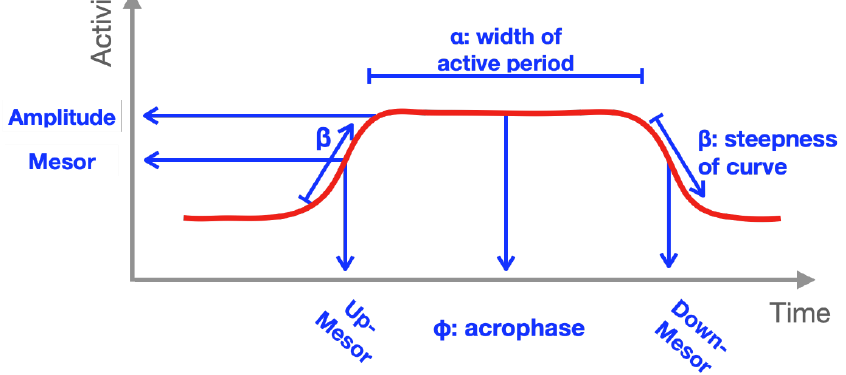
Figure 1. Schematic of parameters estimated from antilogistic extended cosine model and how they impact the size and shape of the rest–activity rhythm.